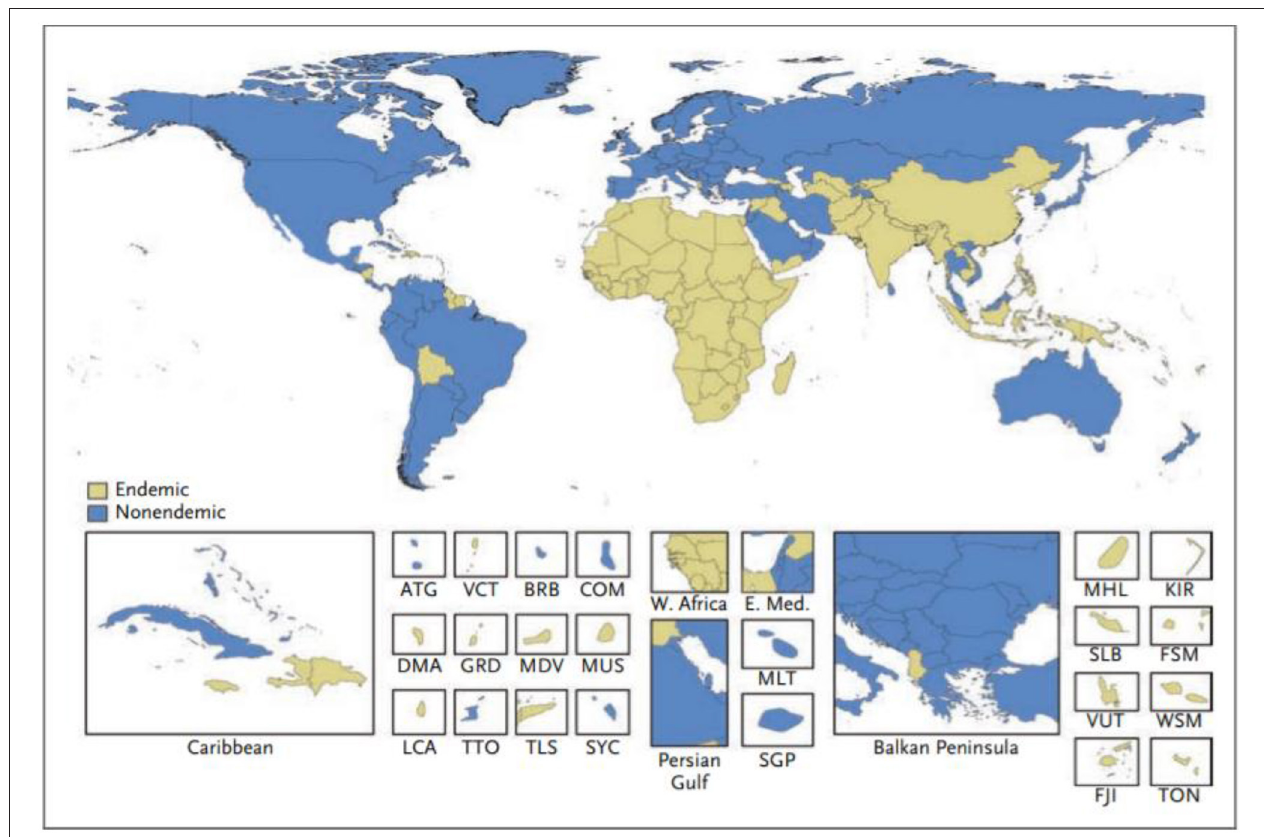
FIGURE 2 | Classification of countries as having an endemic or non-endemic pattern of rheumatic heart disease. A country was classified as having an endemic pattern of disease if its estimated childhood mortality due to rheumatic heart disease was greater than 0.15 deaths per 100,000 population among children 5 to 9 years of age. ATG, Antigua and Barbuda; BRB, Barbados; COM, Comoros; DMA, Dominica; E. Med., Eastern Mediterranean region; FJI, Fiji; FSM, Federated States of Micronesia; GRD, Grenada; KIR, Kiribati; LCA, Saint Lucia; MDV, Maldives; MHL, Marshall Islands; MLT, Malta; MUS, Mauritius; SGP, Singapore; SLB, Solomon Islands; SYC, Seychelles; TLS, Timor-Leste; TON, Tonga; TTO, Trinidad and Tobago; VCT, Saint Vincent and the Grenadines; VUT, Vanuatu; W. Africa, West Africa; WSM, Samoa (